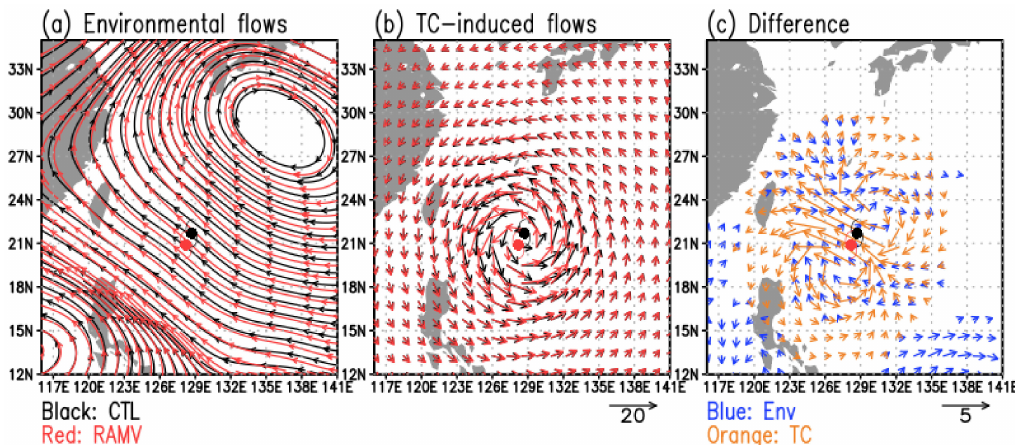
Figure 6. Circulation patterns separated into ( a ) environmental flows, and ( b ) TC-induced flows at 48 forecast hours for Nepartak initialized 1200 UTC 4 July 2016, in CTL (Black) and RAMV (Red). ( c ) Di ff erence in environmental flows with blue vectors and TC-induced flows with orange vectors between RAMV and CTL (RAMV minus CTL). Vector di ff erences smaller than 0.5 m s − 1 are omitted for clarity. TC Symbols display TC position for CTL (Black) and RAMV